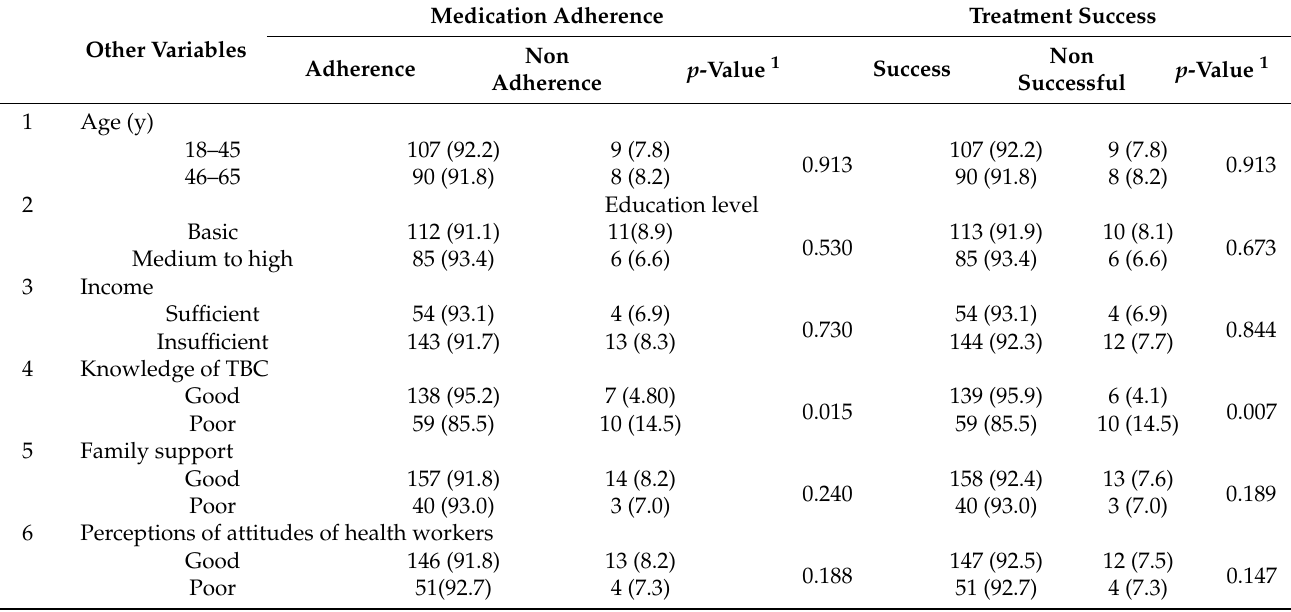
Table 4. Influence of other factors on medication adherence and treatment success ( n =